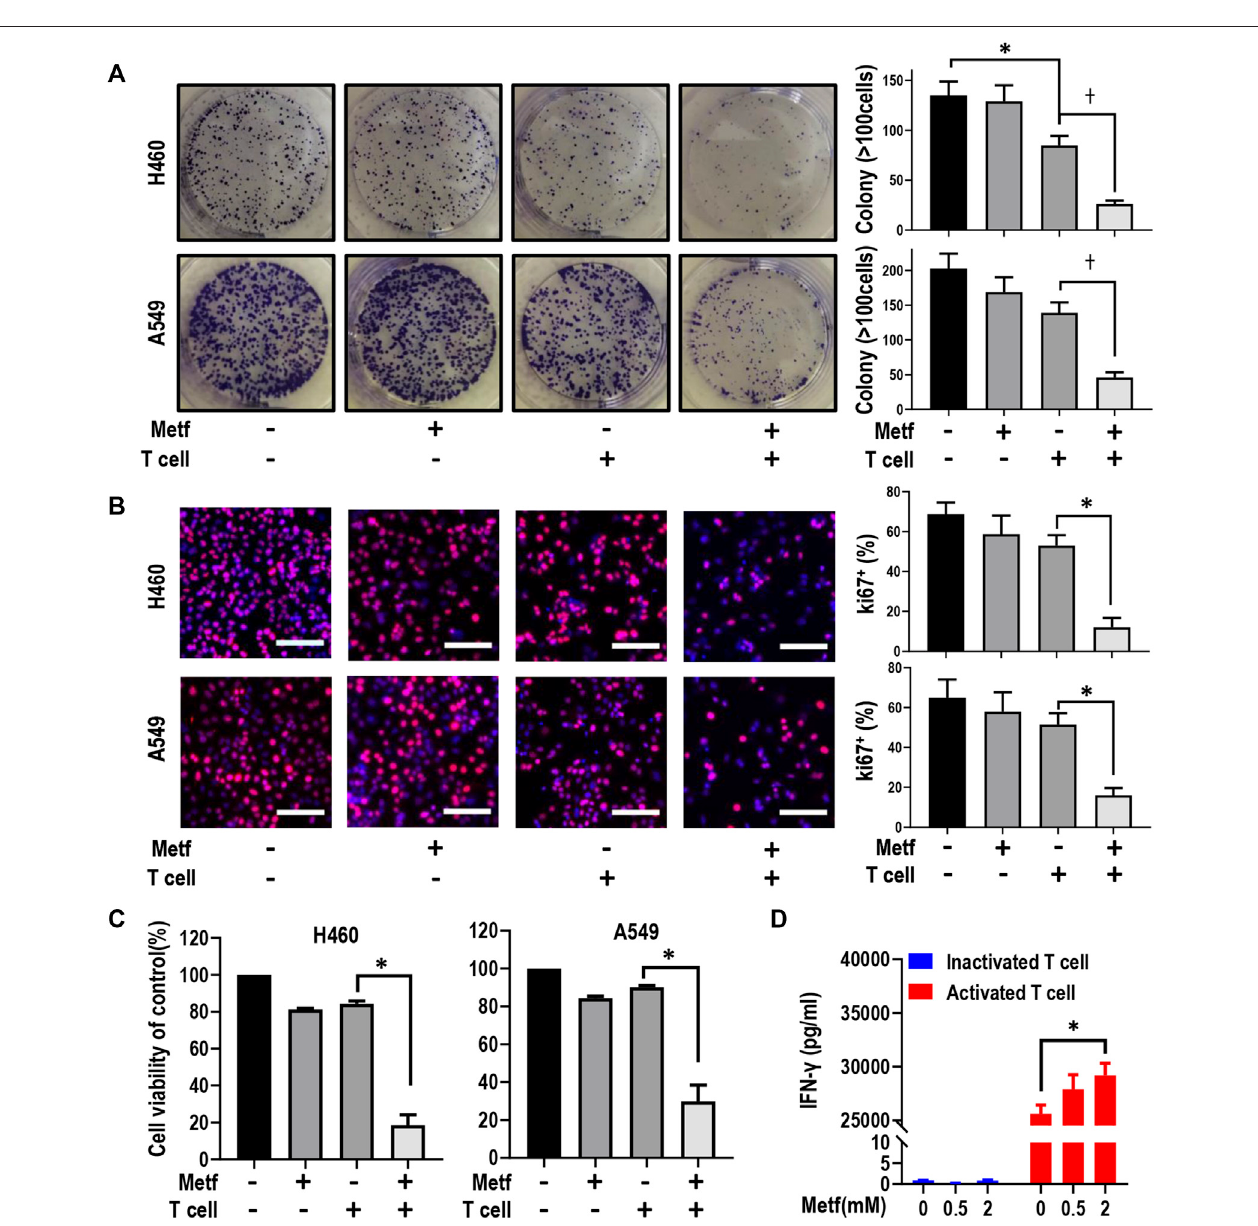
FIGURE1 | Metformin enhanced T cell-mediated killingof lung cancer H460 and A549 cells. (A) , H460 cells and A549 cells wereco-cultured with activated T cells (cancer cells to T cells ratio, 1:1) for 48 h with or without metformin (0.5 mM). Cell colonies were visualized by crystal violet staining. * p < 0.05; † p < 0.01. (B) , Ki67 incorporation assay on H460 cells and A549 cells treated as indicated. Activated T cells (1:1 ratio to cancer cells) or metformin (0.5 mM) were added to the culture medium for 48 h. Cells were then counterstained with DAPI. Data represent mean ± SEM. * p < 0.01. Scale bars: 100 μ m. (C) , Cell viability CCK-8 assay for cells treatedwithmetformin(0.5 mM),oractivatedTcells(1:1ratiotocancercells),orthecombination.Dataareshownasmean±SEMoftriplicatedeterminations.* p < 0.01. (D) , ELISAanalysisoftheprotein expression level ofIFN- γ in inactivated or activated T cellswith thetreatmentwith metformin (0 mM, 0.5 mM, or 2 mM,